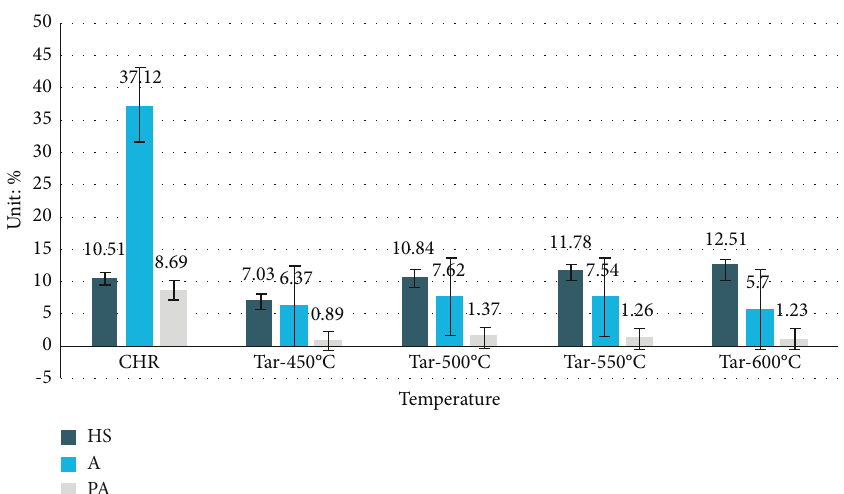
Figure 3: Comparison of residue pyrolysis oil and residue solvent extraction composition at different pyrolysis